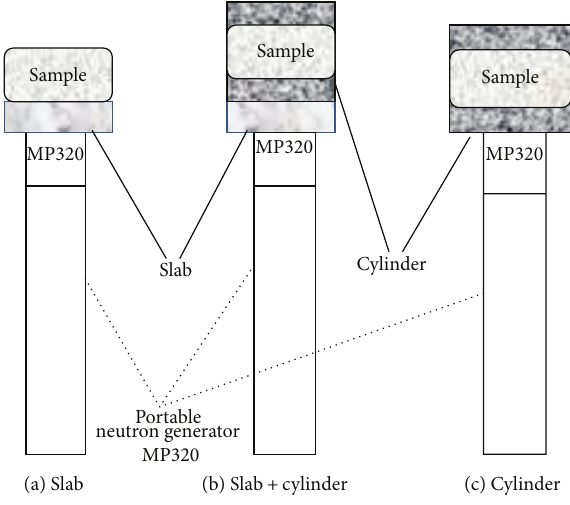
Figure 1: Top schematic view of three different source-moderator- sample geometries of PGNAA setup tested in the present study—(a) source-slab moderator, (b) source-slab-cylindrical moderator, and (c) source-cylindrical moderator.